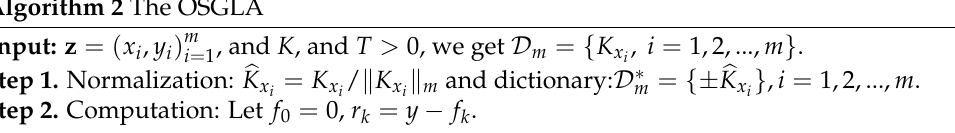
Algorithm 2 The OSGLA